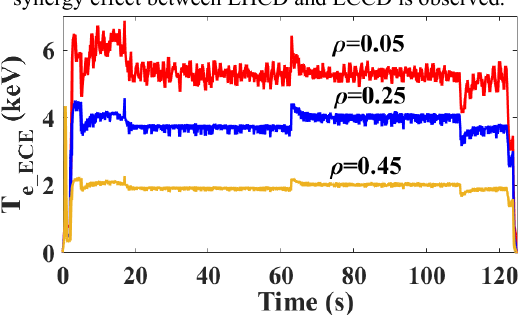
Fig. 13. Electron temperature measured by electron cyclotron emission (ECE) at various positions.